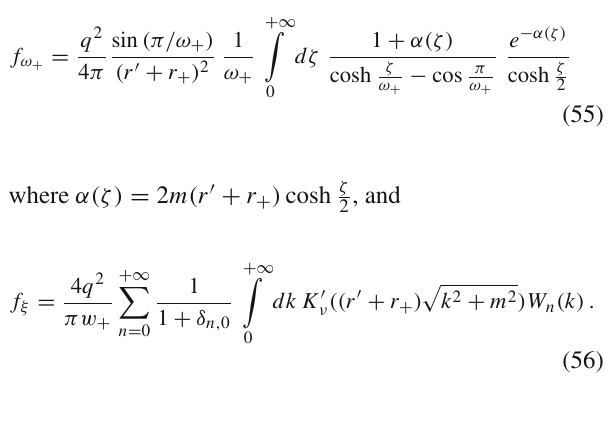
increasing r i m is observed, as shown in the inner region of Figs. 4a and